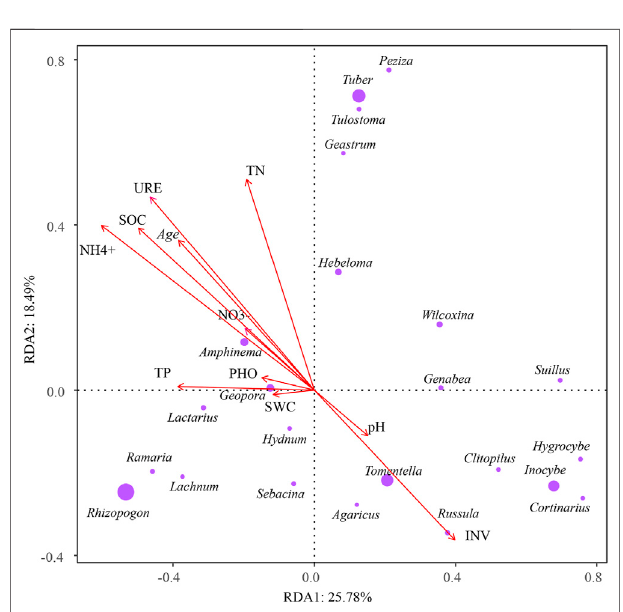
FIGURE 5| RDA illustrating the effects ofsoil characteristics on the EcM fungal community. The red arrow represents soil characteristics. The purple circle represents EcM fungi, and the size of the circle represents the relative abundance. The arrow direction and length indicate correlation to EcM fungal composition and effect size of the variables.